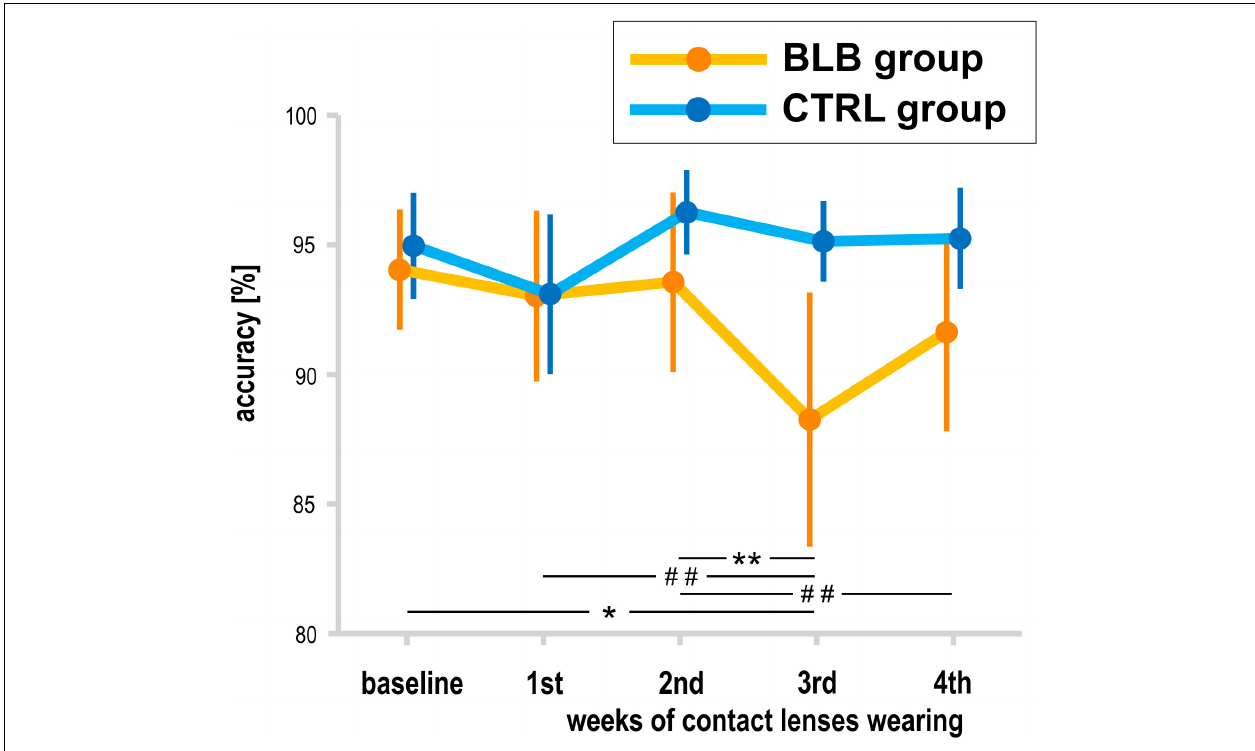
FIGURE 6 | Accuracy in sequential picture location task (SPLT) for the blue light blocked (BLB) and control (CTRL) groups for the baseline and 4 weeks of experimental condition. ** p < 0.01; * p < 0.05; ## p < 0.1; bars indicate standard